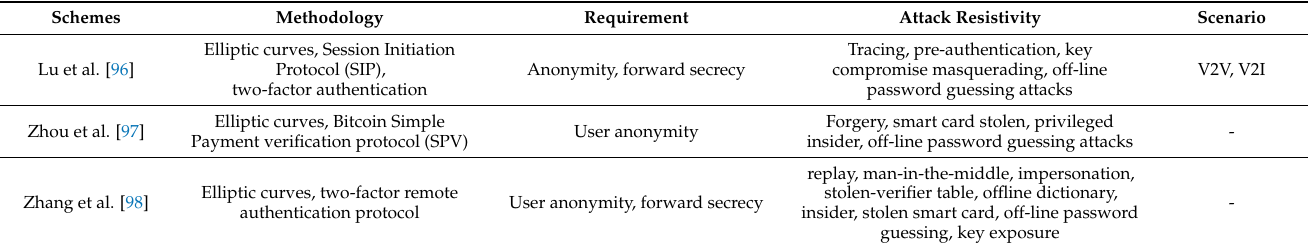
Table 8. Classification of smart card (two-factor) authentication